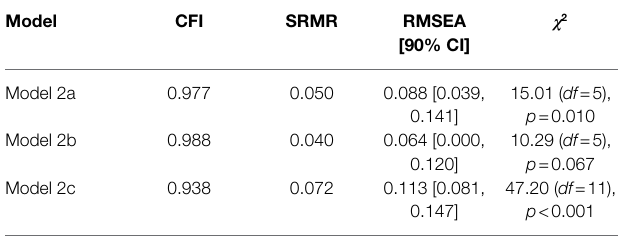
TABLE 3 | Fit indices for the models in Figures 4 – 6 .